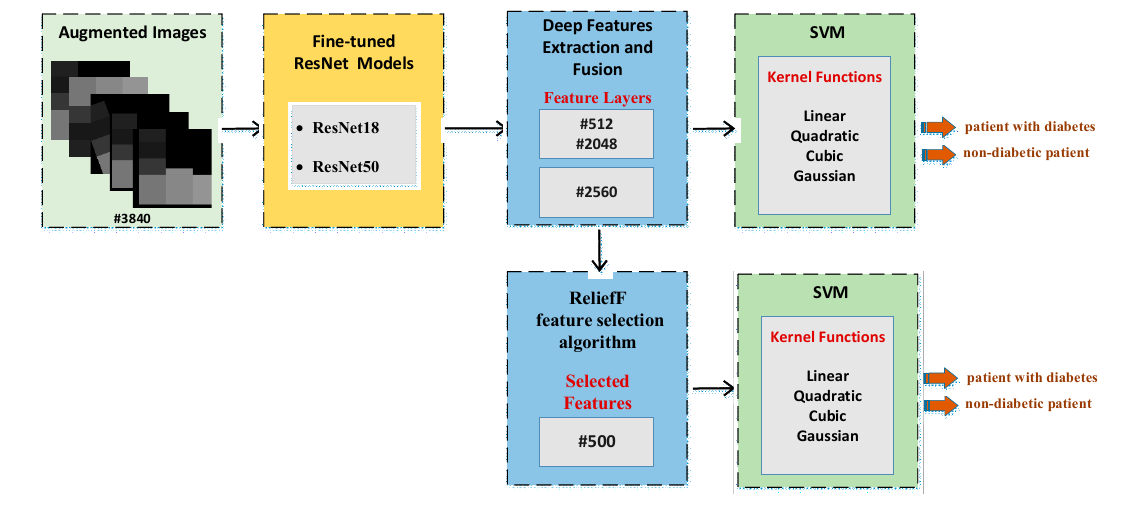
Figure 7. Implementation steps of the proposed CNN-SVM approach.